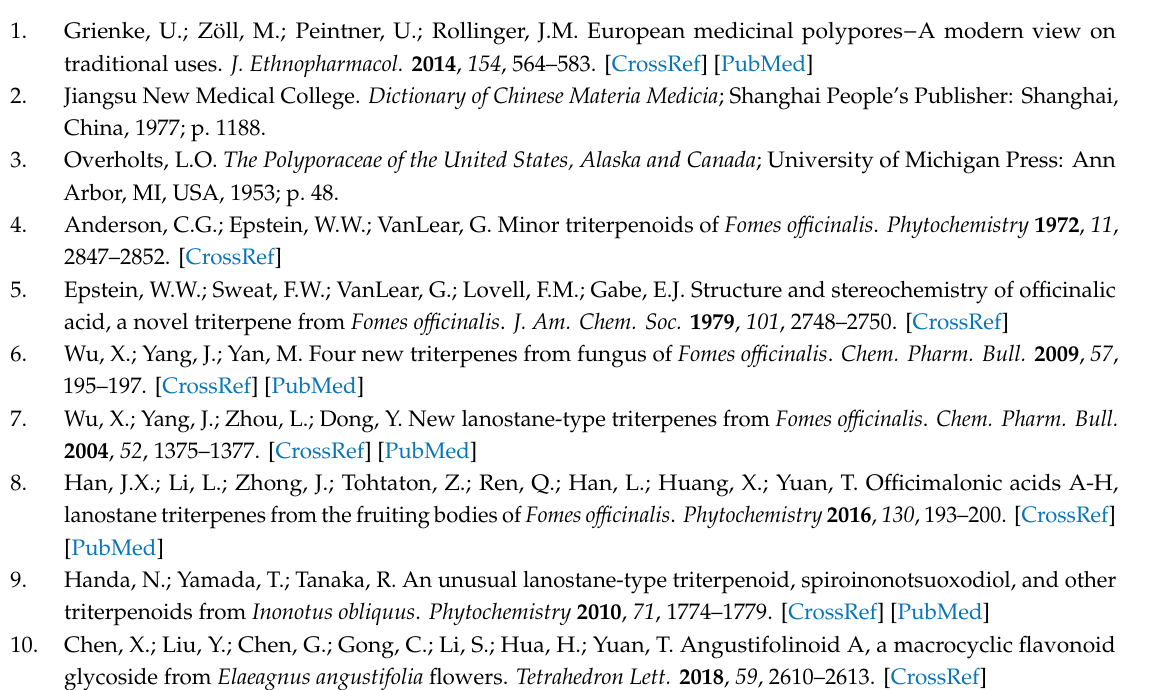
13 C-NMR spectrum of o ffi cimalonic acid M ( 5 ) in CD 3 OD. Figure S20: HR-ESI-MS spectrum of o ffi cimalonic acid M ( 5 ). Figure S21: 1 H-NMR spectrum of o ffi cimalonic acid N ( 6 ) in CD 3 OD. Figure S22: 13 C-NMR spectrum of o ffi cimalonic acid N ( 6 ) in CD 3 OD. Figure S23: HR-ESI-MS spectrum of o ffi cimalonic acid N ( 6 ). Figure S24: 1 H-NMR spectrum of o ffi cimalonic acid O ( 7 ) in CDCl 3 . Figure S25: 13 C-NMR spectrum of o ffi cimalonic acid O ( 7 ) in CDCl 3 . Figure S26: HR-ESI-MS spectrum of o ffi cimalonic acid O ( 7